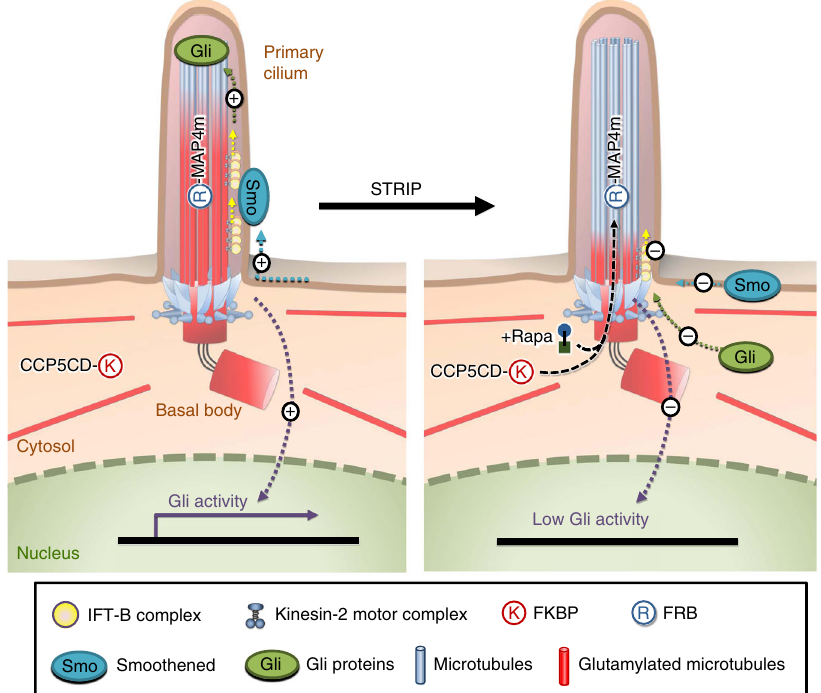
Fig. 8 Model of our inducible axonemal deglutamylation system, STRIP, and proposed roles for tubulin glutamylation. The proximal end of the axoneme is subjected to polyglutamylation. Axonemal glutamylation facilitates kinesin-2-mediated anterograde IFT and the ciliary entry of the Hedgehog pathway components Smoothened (Smo) and Gli3 upon Hedgehog stimulation. The translocation of the CCP5 catalytic domain (CCP5CD) onto the MAP4m- appended axoneme by adding rapamycin speci fi cally strips axonemal glutamylation and subsequently inhibits anterograde IFT and Hedgehog signaling without noticeably affecting the ciliary structure in the steady